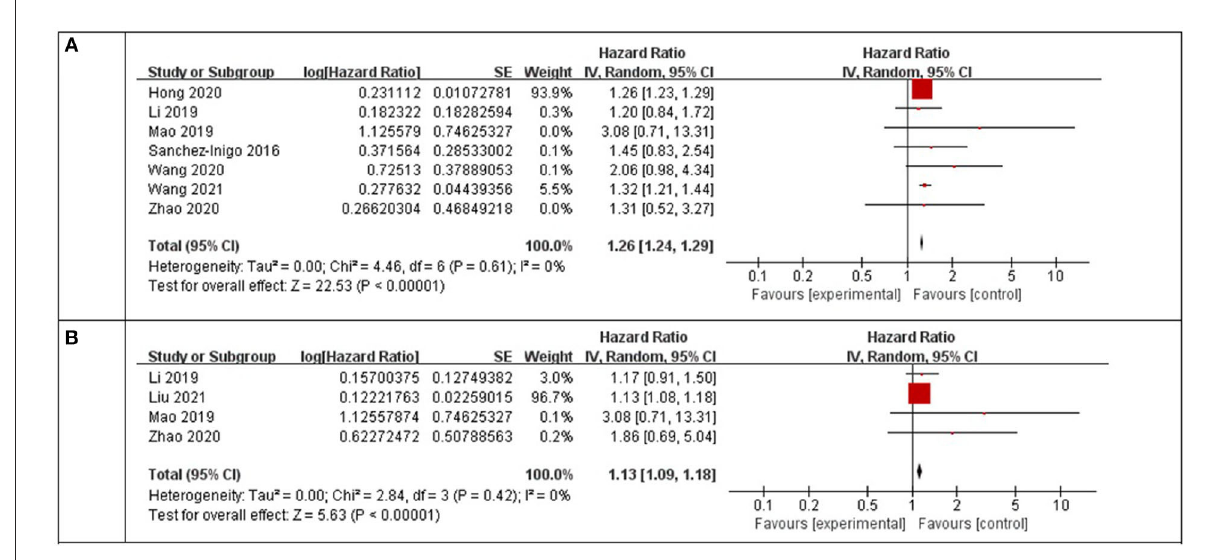
FIGURE2 Forest plots for the meta-analysis of the association between the TyG index and the risk of stroke. (A) Meta-analysis with the TyG index analyzed as a categorical variable. (B) Meta-analysis with the TyG index analyzed as a continuous